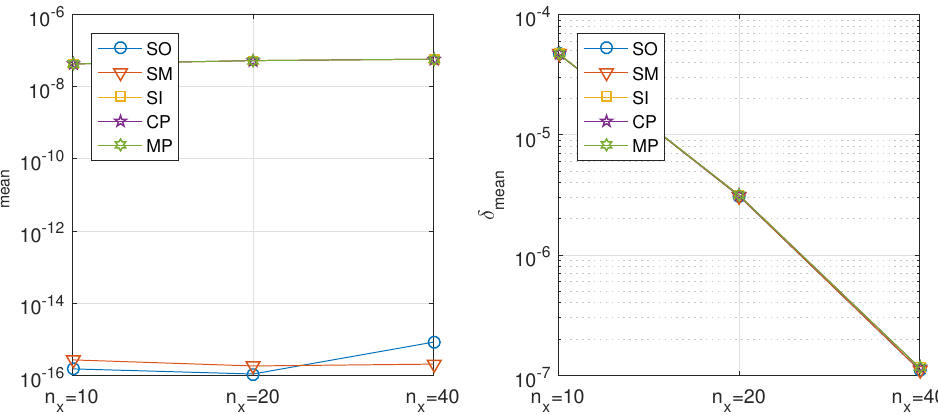
Figure 5. Diffusion problem, directional decomposition. Precision of the proposed methods: sequential iterative SI, classical parallel CP, and modern parallel MP, compared with the classical ones: sequential operator SO and Strang–Marchuk SM, with fourth order approximations for the spatial derivatives for different number of spatial